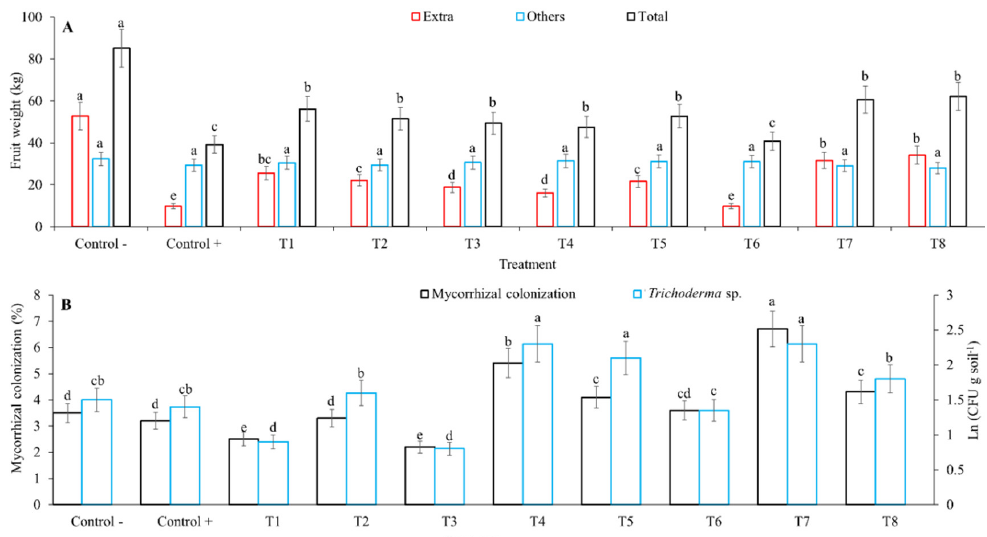
Figure 5. Quantity and quality of fruit production, mycorrhizal colonization, Trichoderma sp. inoculum and in management practices of V . dahliae under field conditions. ( A ): Production and quality of Hass avocado crops under different treatments for V . dahliae . ( B ): mycorrhizal colonization and inoculum of Trichoderma sp. quantified under different treatments of wilt disease. Error bars represent the confidence interval of the mean, validated by Tukey mean separation test. Equal letters indicate that there are no significant differences ( p > 0.05). The following treatments were evaluated under field conditions (where “fi” stands for field conditions): fi—healthy control: non-inoculated control of healthy plants; fi—diseased control: plants infected with V . dahliae ; T1fi (fungicide): Verticillium -infected plants + application of fungicide in drench (benomyl in rotation with azoxystrobin); T2fi (pruning): Verticillium -infected plants + sanitary pruning; T3fi (solarization): Verticillium -infected plants + solarization; T4fi (Trichoderma-mycorrhiza-sucrose): Verticillium -infected plants + soil inoculation with Trichoderma sp. and R . fasciculatum ; T5fi (organic matter): Verticillium -infected plants + application of compost; T6fi (drainage): Verticillium -infected plants + a drainage network around the base of the stem; T7fi (pruning-solarization-Trichoderma-mycorrhiza-sucrose-organic matter-drainage): Verticillium -infected plants + integrated management proposal without fungicide consisting of simultaneous application of T2fi+T3fi+T4fi+T5fi+T6fi; and T8fi (fungicide-pruning-solarization-Trichoderma-mycorrhiza-sucrose-organic matter-drainage): Verticillium -infected plants + integrated manage- ment proposal with fungicide consisting of simultaneous application of T1fi+T2fi+T3fi+T4fi+T5fi+T6fi.